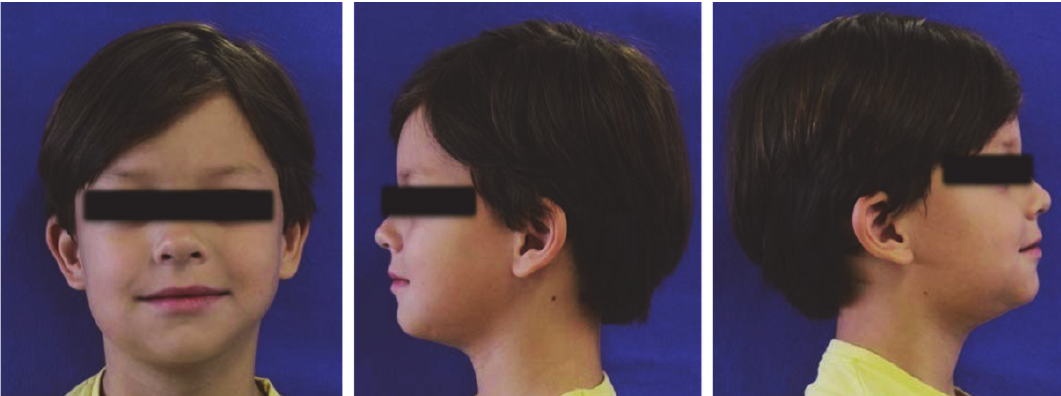
Figure 1: The initial clinical aspect of the child. Note the presence of swelling on the right lower third of the face.